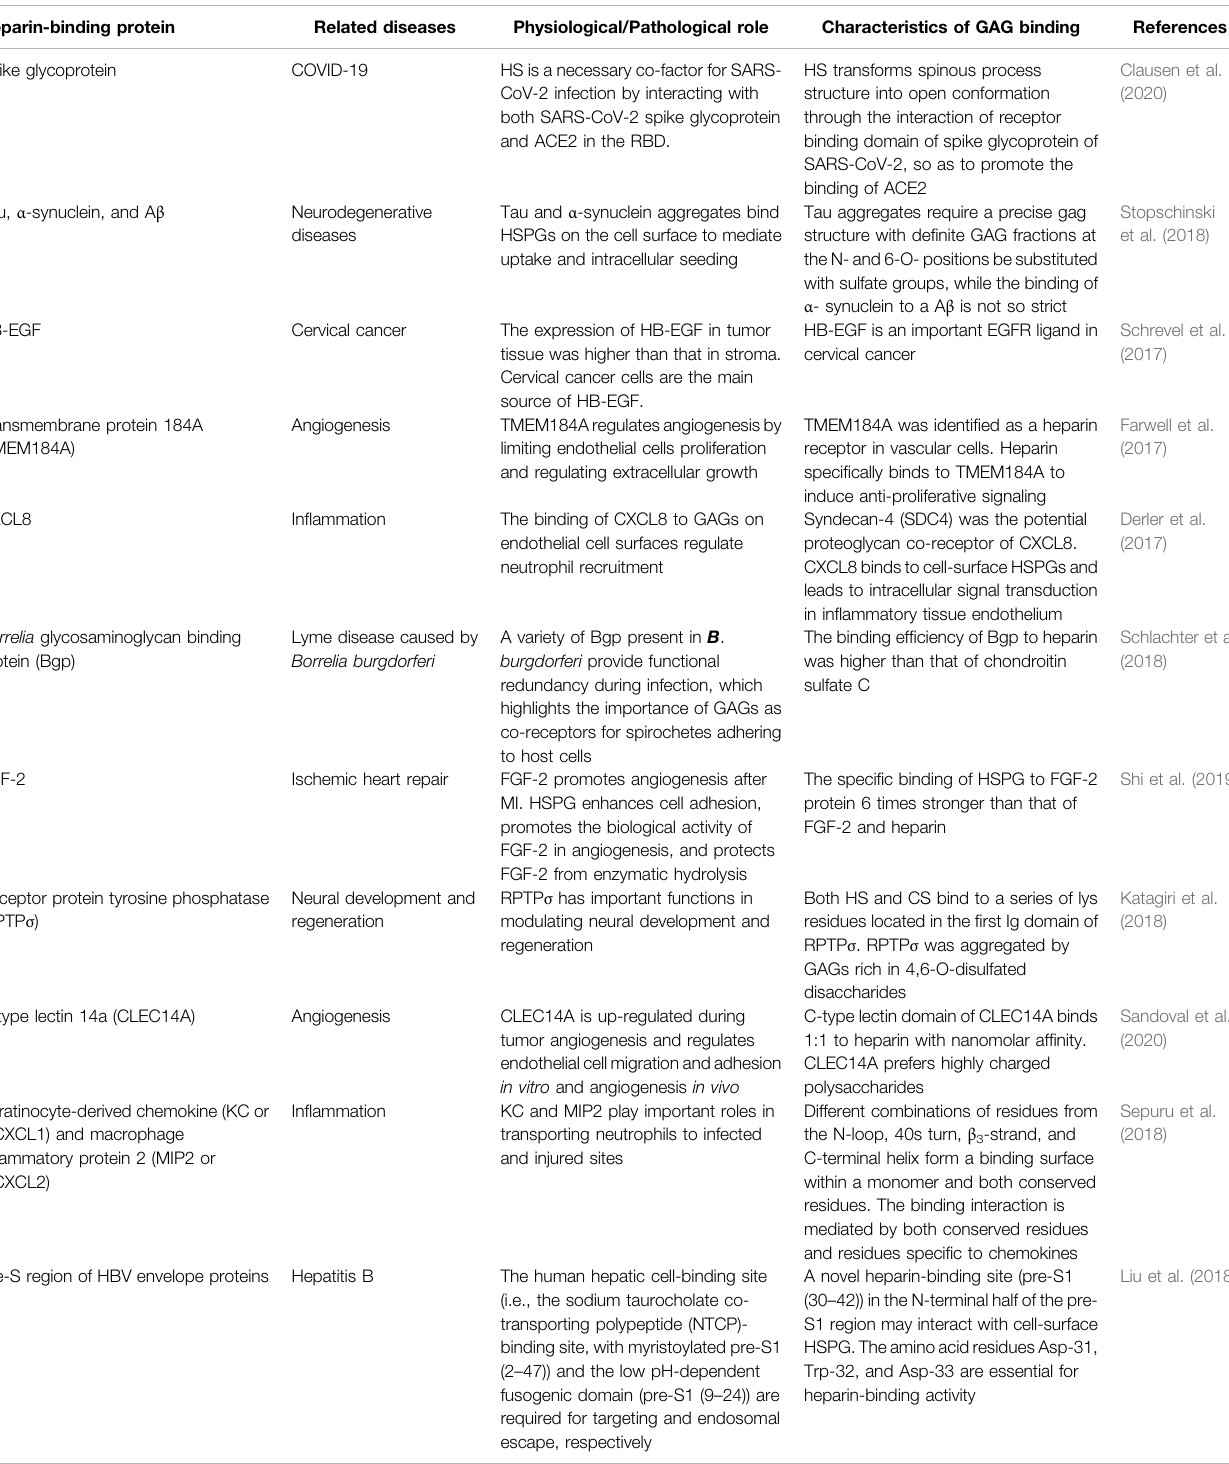
TABLE 1 | An update of selected families of GAG binding proteins is